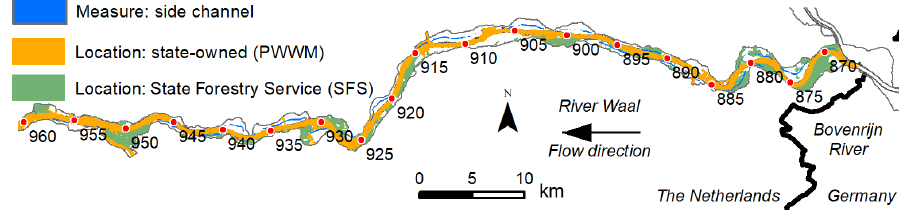
Figure 4. Location of the two largest stakeholder, the state (Public Works and Water Management) and the State Forestry Service (SFS). The other public and private stakeholders own the remaining areas in white. The location of the side channels represents the smooth option for the whole area (AS). Water flows right to left. Measures are implemented over the whole reach, independent of the reference water level being exceeded.